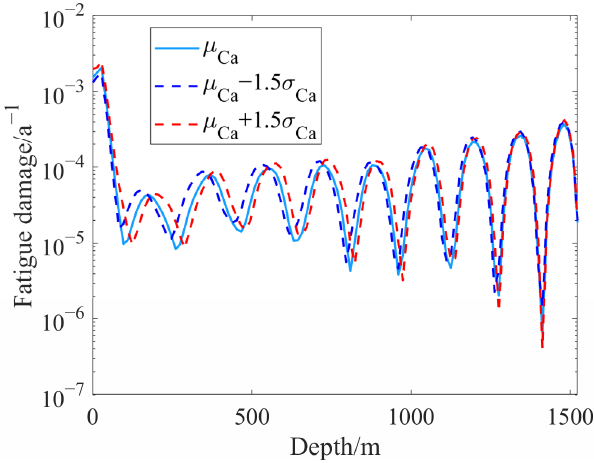
Figure 9. Effect of C a on fatigue damage.